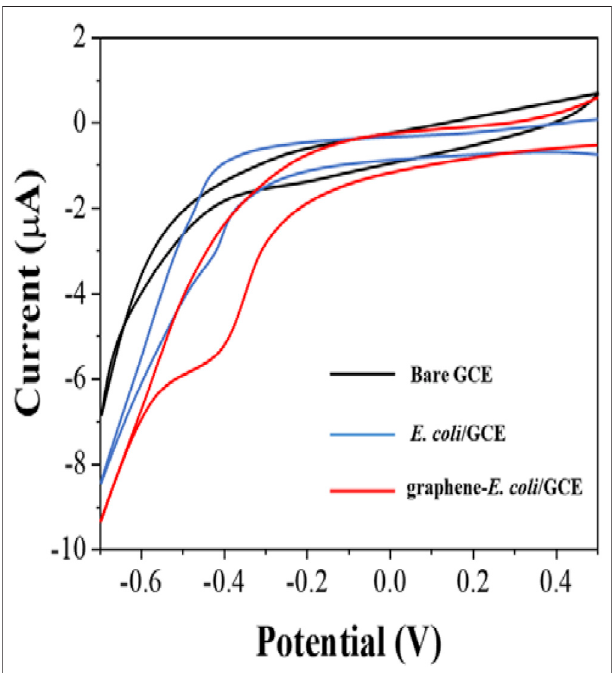
FIGURE 1 | CVs of bare GCE, E. coli /GCE and graphene- E. coli /GCE in PBS (pH (cid:2) 7).